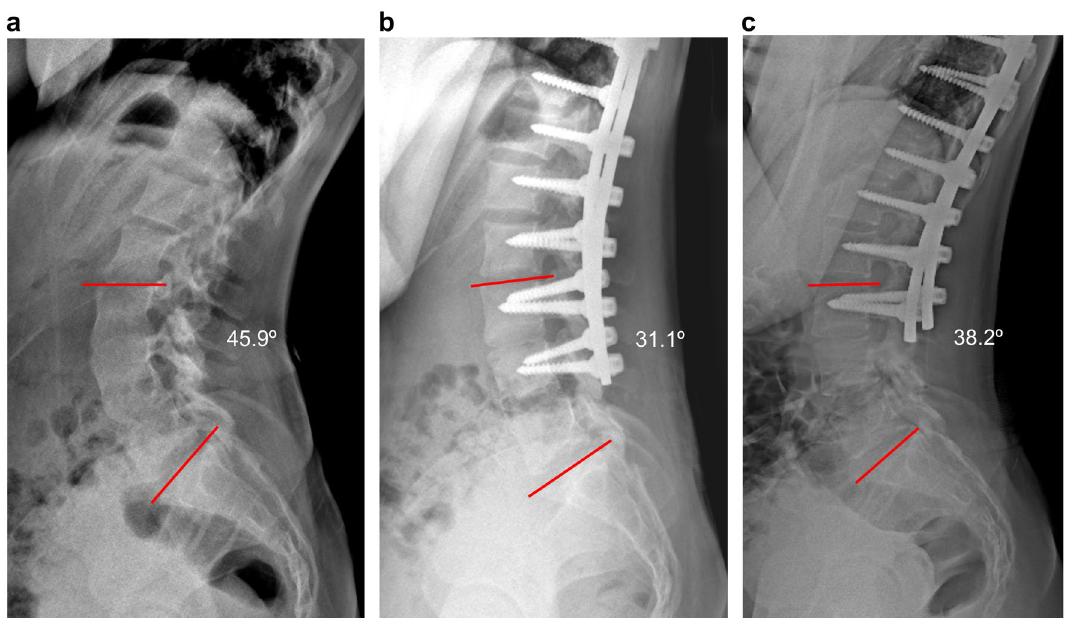
Figure 5. L3/S1 lordosis in whole spine lateral images of the same patient shown in Fig. 3–1 ( a ) Preoperative L3-S1 lordosis is 45.9°. ( b ) After the first surgery (L4 transient fixation), the L3-S1 lordosis angle is 31.1°. ( c ) After the second surgery (final follow-up), the L3-S1 lordosis angle is 38.2°; the lumbar lordosis is slightly